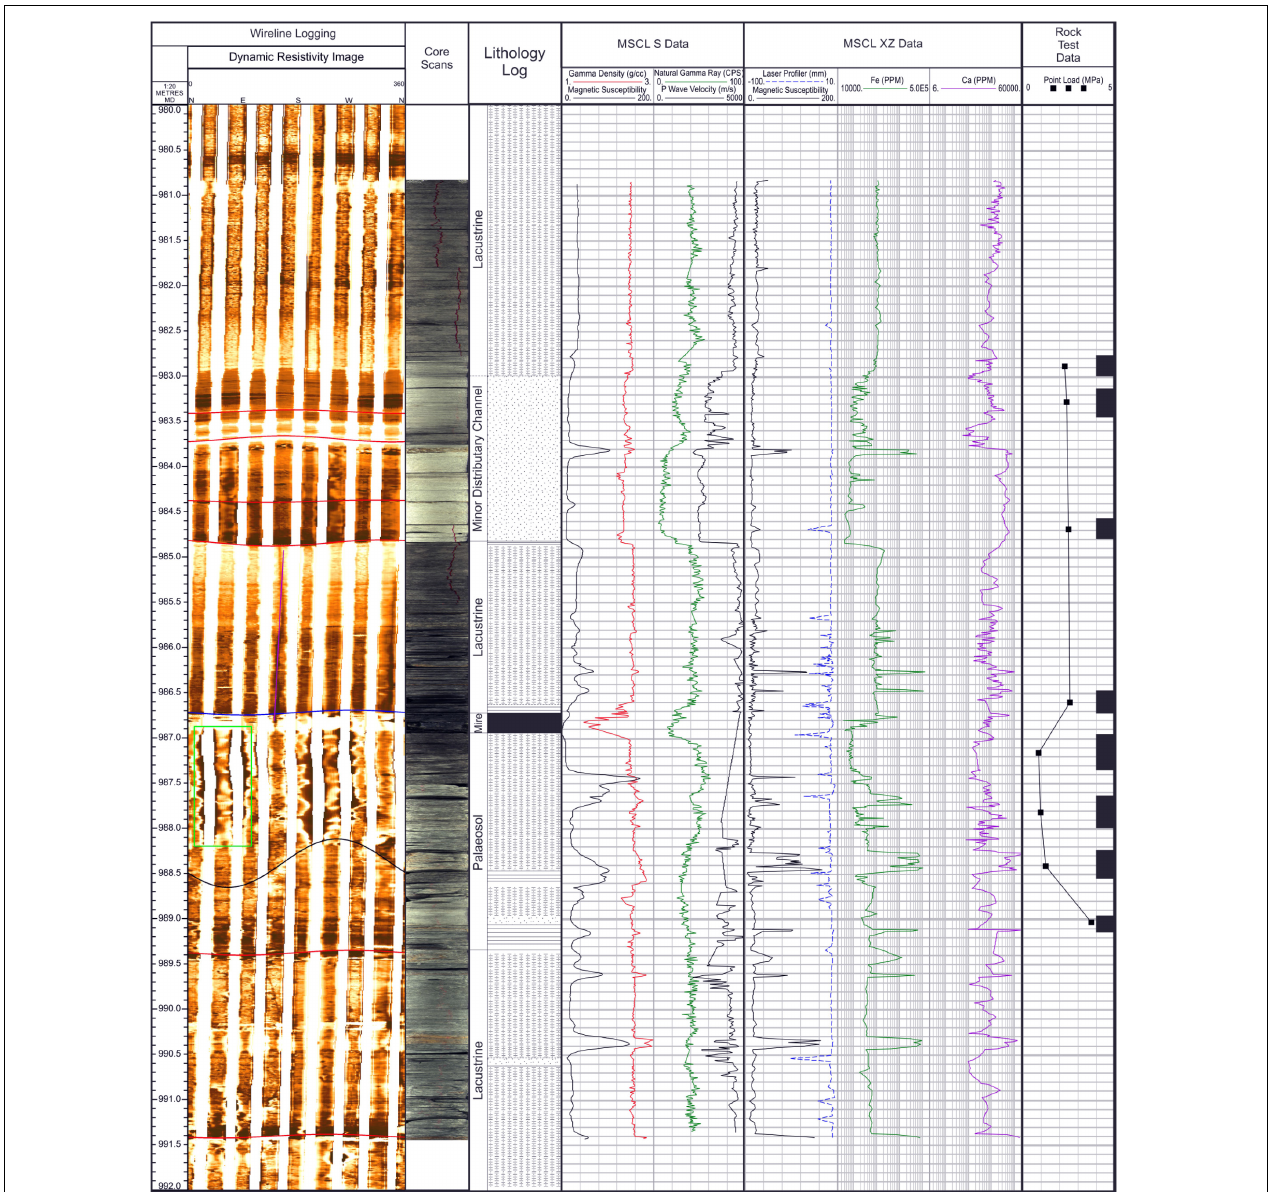
FIGURE 9 | Depth matched plot showing the outputs of the Core Scanning and the Point Load testing for the Melbourne 1 Borehole. Left Panel, Unwrapped resistivity image (clockwise from North), breakouts highlighted by green boxes, and core images. Center Left Panel, Optical line scan images of the core from the MSCL-S and simplified lithology log derived from Figure 3 . Center Panel, Selected outputs from MSCL-S physical property data including: density, p-wave velocity and gamma ray. Center Right Panel, Outputs from the MSCL-XZ showing: Iron, Calcium, and magnetic susceptibility. Right Panel, results from the Point Load testing, the intervals over which Point Load Strength (Is ( 50 ) ) was calculated are shown by the black rectangles with Is ( 50 ) plotted at the mid-point of these zones.